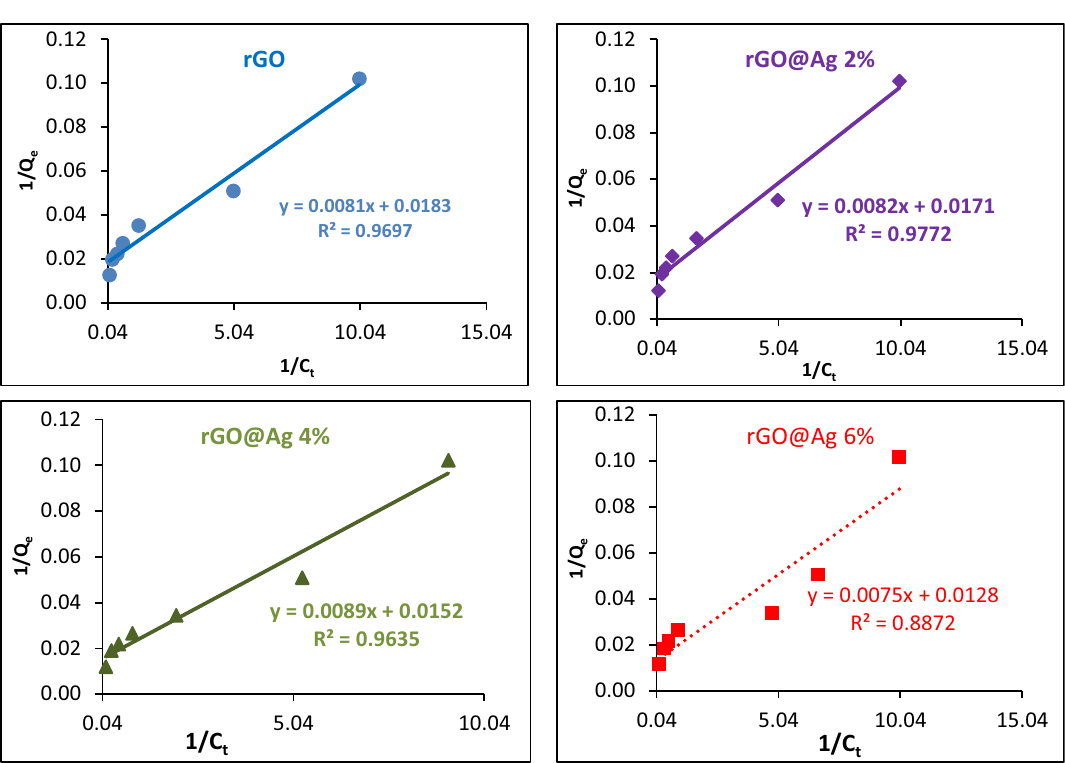
Fig. 12 Graph of Langmuir isotherm model for CR degradation using as-synthesized rGO and rGO@Ag x %